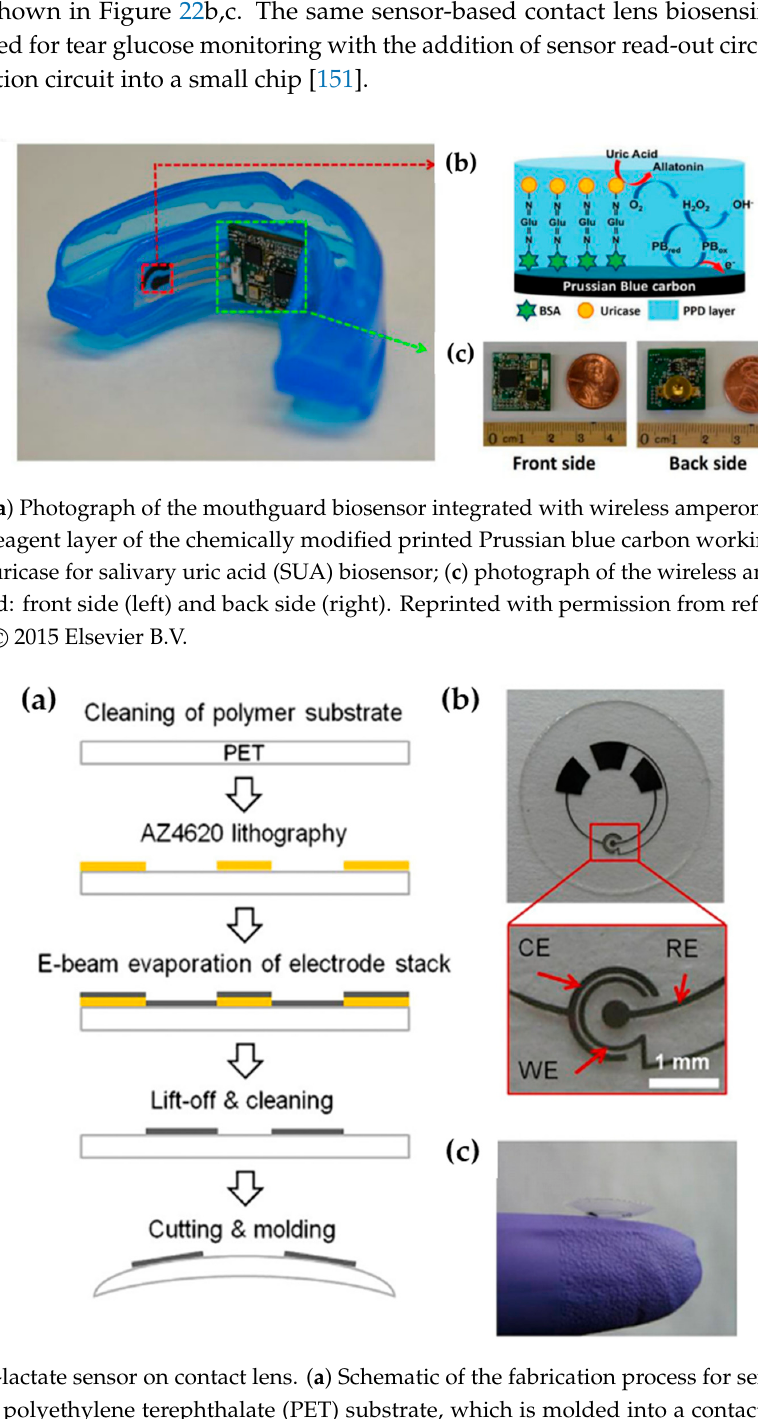
Figure 22. l-lactate sensor on contact lens. ( a ) Schematic of the fabrication process for sensors on the transparent polyethylene terephthalate (PET) substrate, which is molded into a contact lens shape; ( b ) flat substrate with sensing structure, interconnects and electrode pads for connection to the external potentiostat; ( c ) completed contact lens sensor held on a finger. Reprinted with permission from reference [150]. Copyright © 2011 Elsevier B.V.